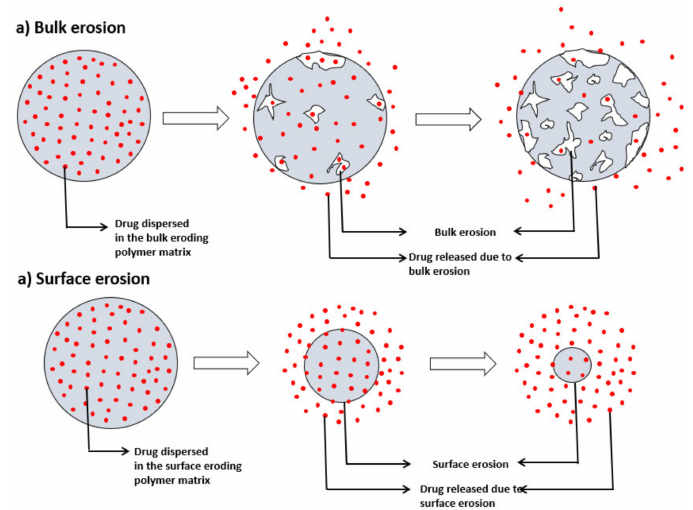
Figure 30. Schematic of bulk erosion and surface